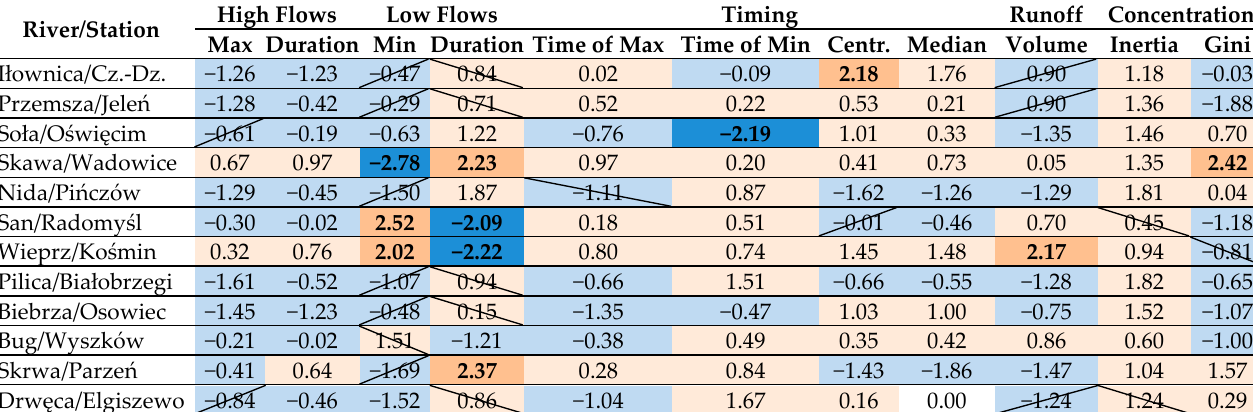
Table 8. Results of the Mann test ( uF statistics) for trends in the summer season daily flow characteristics at hydrological stations on the Vistula tributaries; orange colour denotes positive uF values, blue colour negative. The marks represent the diagonal lines from the upper left corner to the lower right to show that the value can decrease if autocorrelation is taken into account and the opposite is true for the cases when the autocorrelation causes an increase in the presented value. Numbers in bold indicate statistically significant changes at α level 0.05.